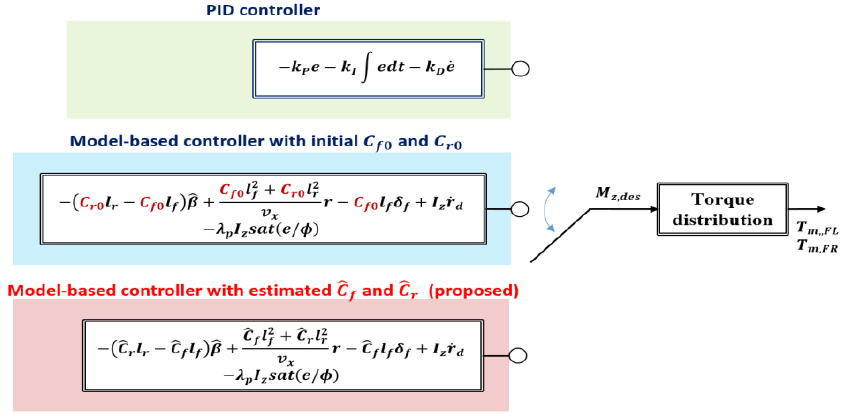
Figure 6. Comparison targets in simulation.